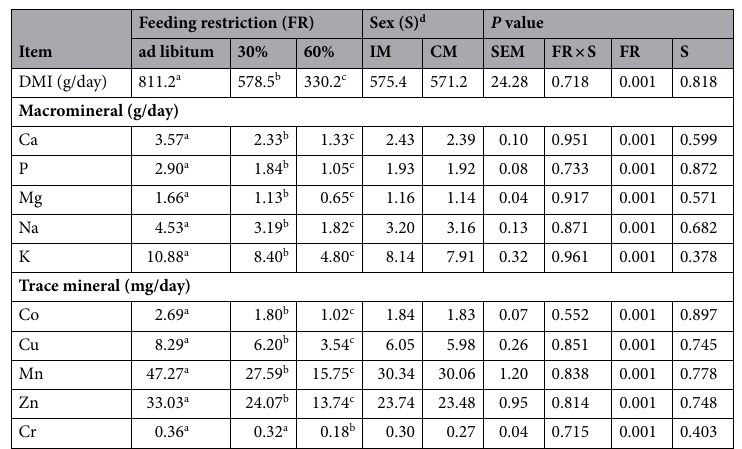
Table 2. Dry matter and mineral intake of intact and castrated male Santa Ines hair sheep. d IM intact male, CM castrated male, DMI dry matter intake. Different letters ( abc ) indicate that the feeding restriction differed ( P < 0.05; Tukey–Kramer test).